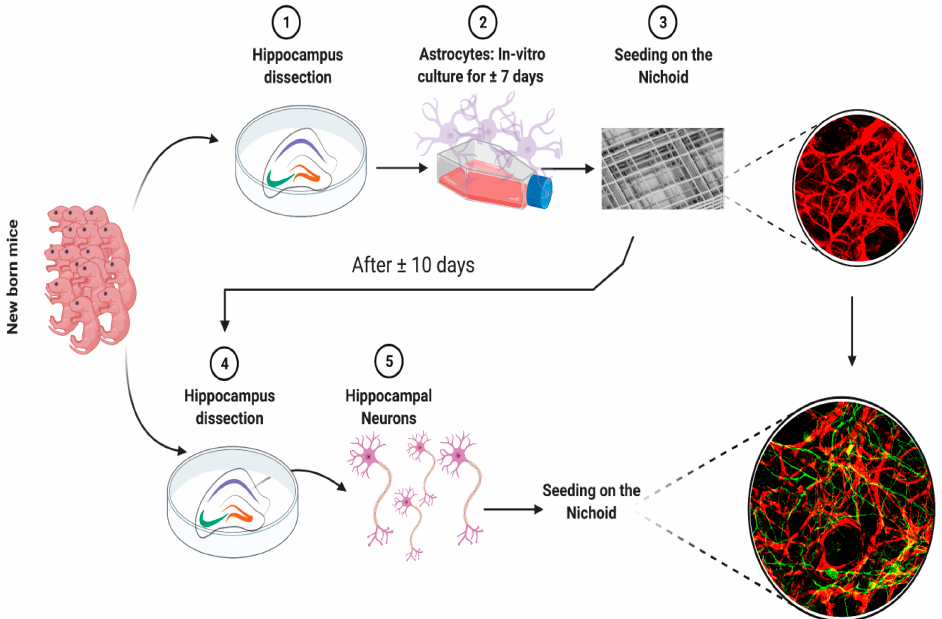
Figure 1. Schematic illustration of the primary hippocampal astrocyte—neuron co-culture set-up in the 3D synthetic microscaffold Nichoid.